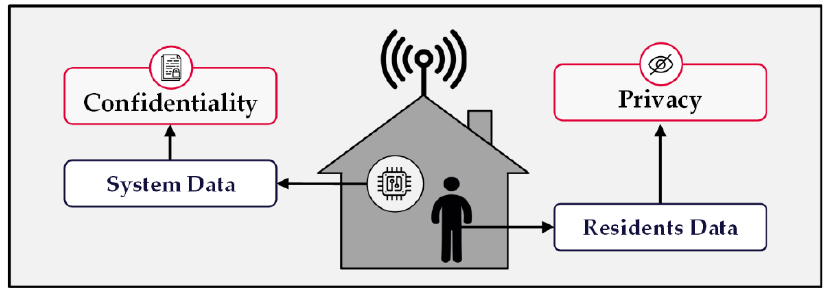
Figure 2. Types of home data and their related security measures.